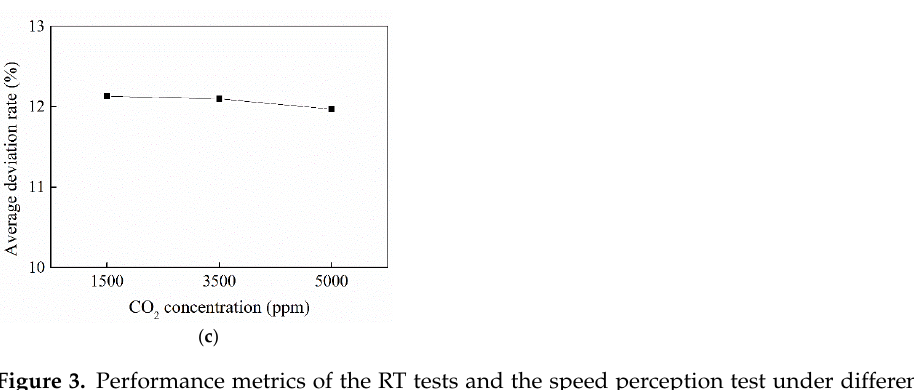
( a ) ( b ) Figure 5. Performance metrics of the 2-back test under different CO 2 conditions. ( a ) Accuracy. ( b ) Response time.